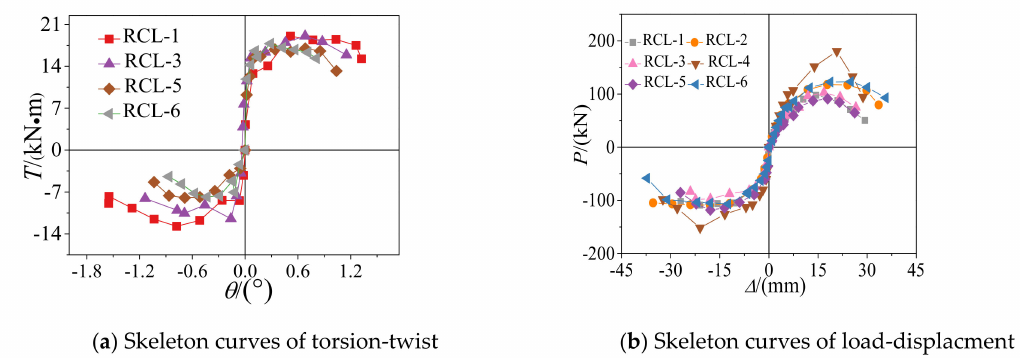
Figure 8. Skeletion curves for the